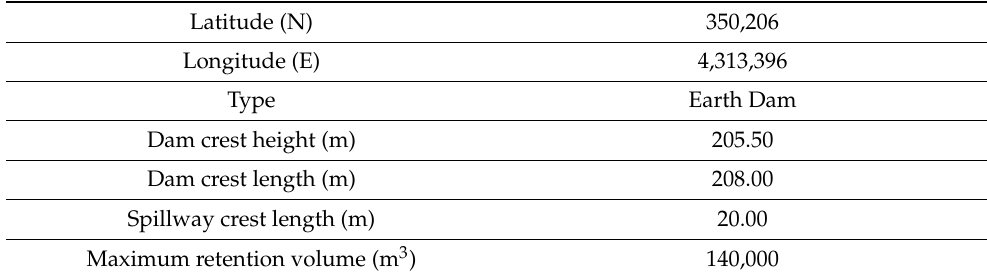
Figure 1. Geological map of the study area in Central Greece (Platana dam; scale 1:50,000) [74]. In this paper, the lowest downstream point of the main drainage area studied was The Platana dam is an embankment (rockfill with an impervious core) dam. Its fea- defined as the basin’s outlet located 150 m upstream of the dam. tures are presented in Table 1 and Figure 2. Table 1. Platana dam characteristics.